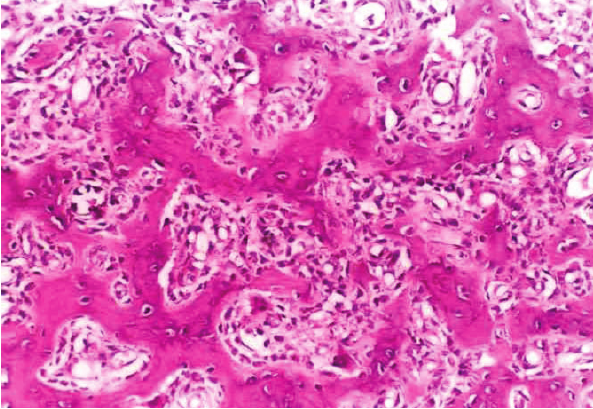
Figure 2 - Classical histologic aspects of osteoblastoma with long inter anastomosing trabeculae of woven bone and osteoid rimmed by a single